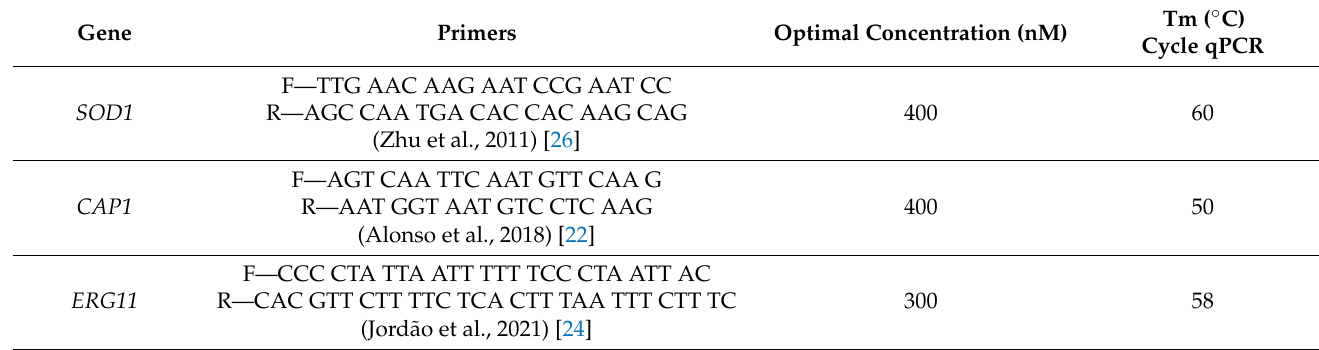
Table 1. Specific primers for the expression analysis of the SOD1 , CAP1 , and ERG11 genes were acquired and standardized with the ideal concentration for the qPCR